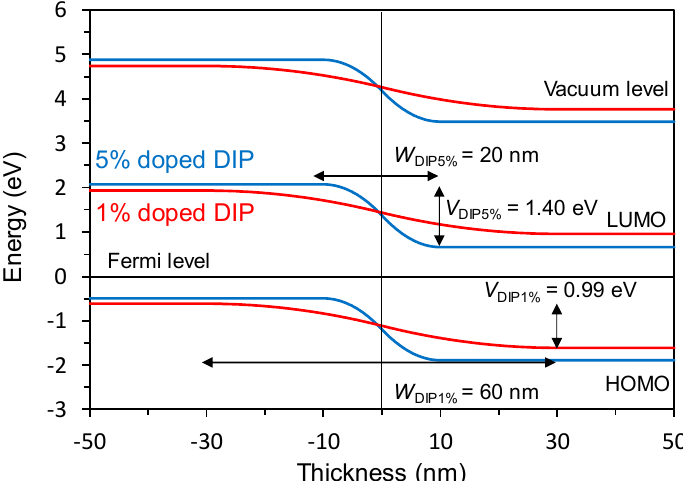
Figure 4. Vacuum level, HOMO, and LUMO energy levels relative to the Fermi level in the 1% doped DIP (red) and 5% doped DIP (blue) devices as a function of film thickness. These results are based on